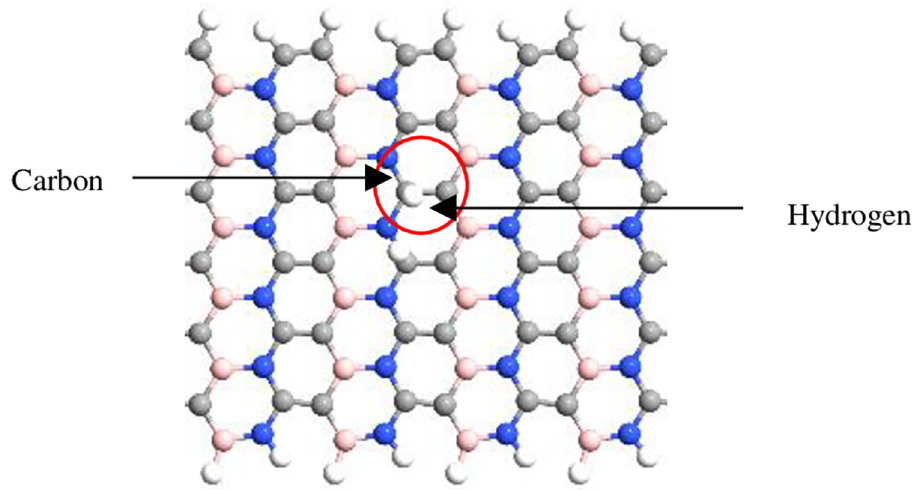
Fig 5. Optimized structures of 12-BC 2 NNR with multiple H 2 gas molecules in different positions at carbon atom.